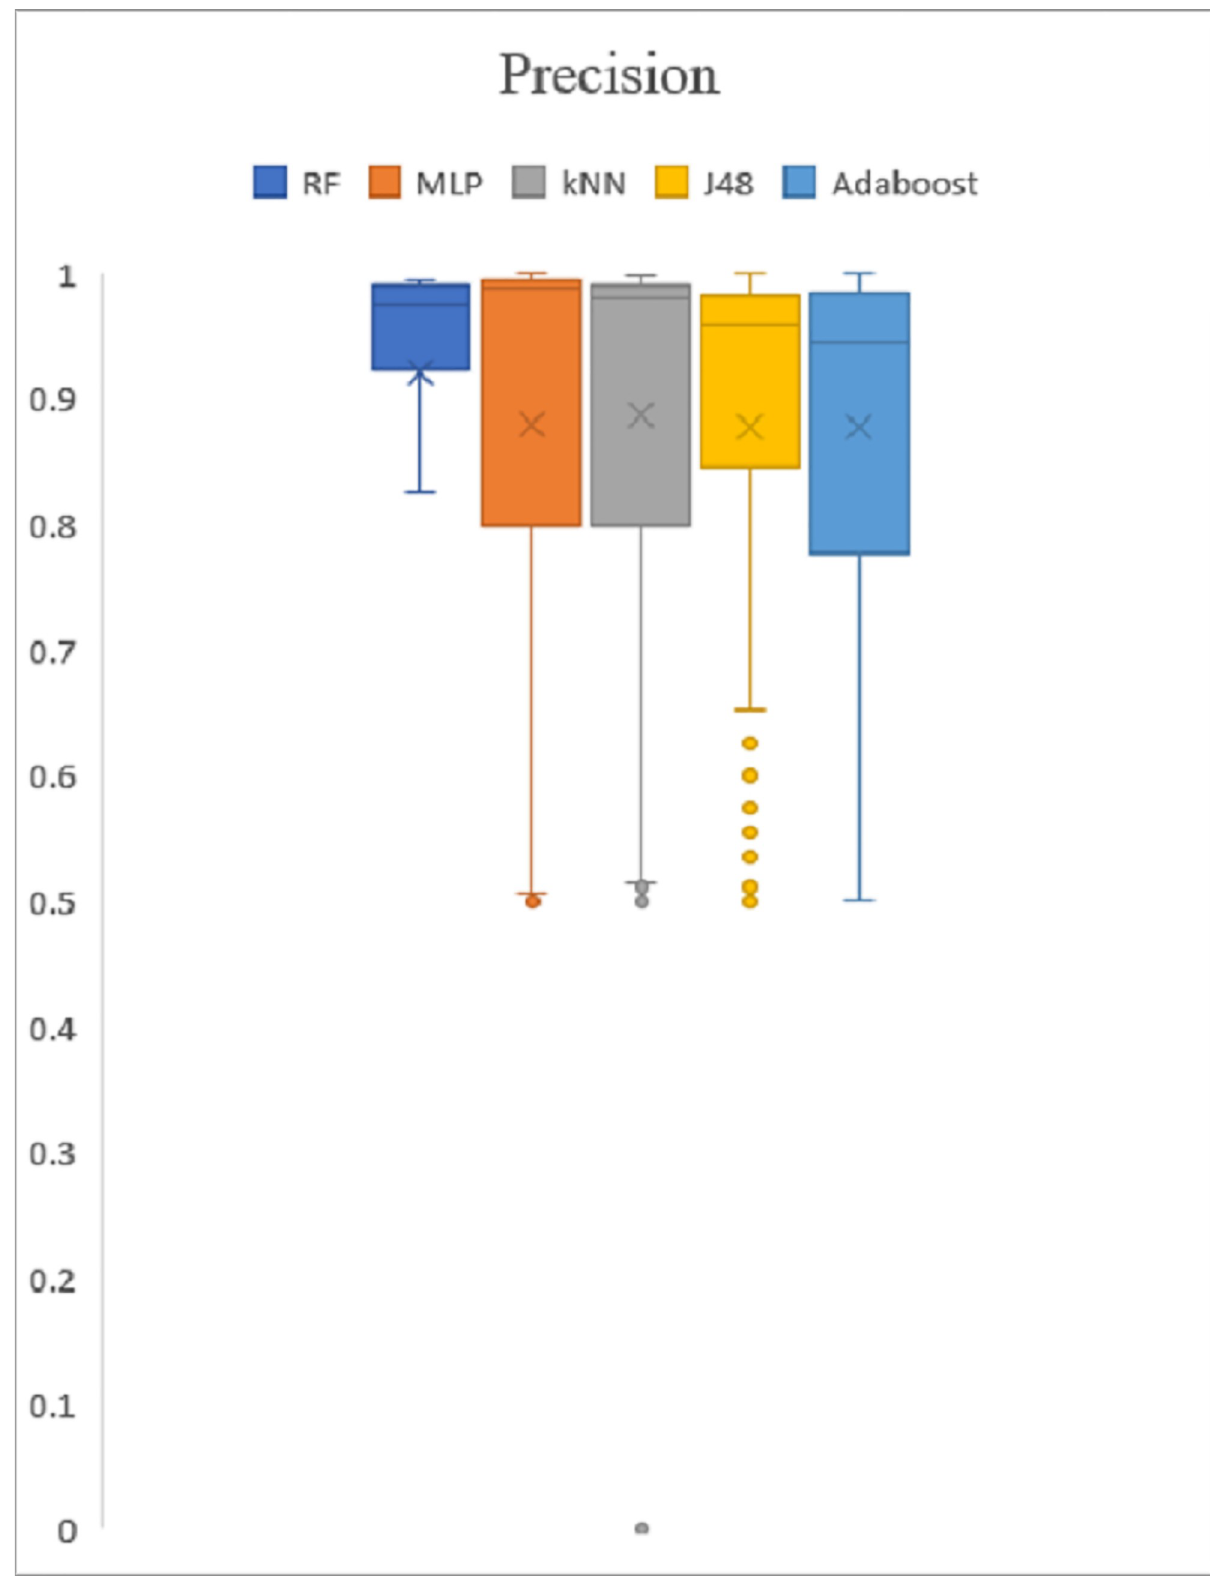
Fig 9. Precision. https://doi.org/10.1371/journal.pone.0257968.g009 PLOS ONE | https://doi.org/10.1371/journal.pone.0257968 September 30,